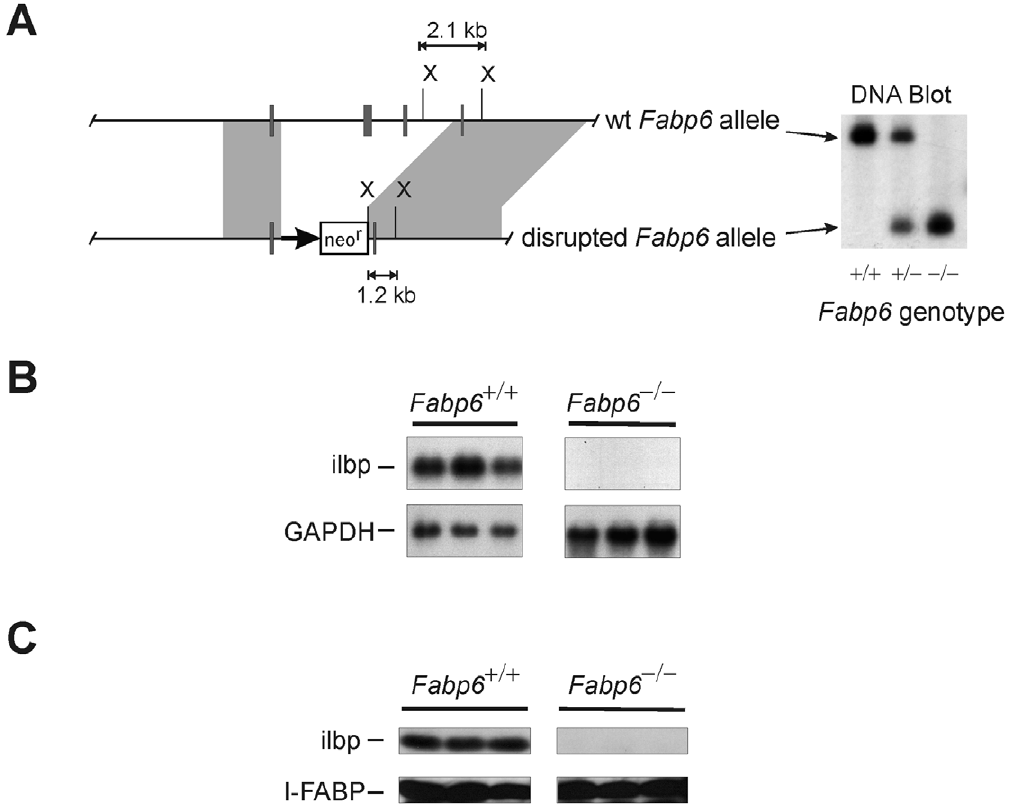
Figure 1. Targeted disruption of the murine Fabp6 gene. (A) Structure of wild-type (wt) and disrupted Fabp6 alleles. The targeting vector was designed to replace the region of the Fabp6 gene encompassing exons 2 and 3 with the neo resistance (neo r ) gene cassette. X, Xba I site. (B) RNA blot of small intestine RNA from Fabp6 + / + and Fabp6 2 / 2 mice probed with [ 32 P]-labeled ilbp cDNA. (C) Protein blot of small intestine homogenates from Fabp6 + / + and Fabp6 2 / 2 mice probed with antiserum to murine